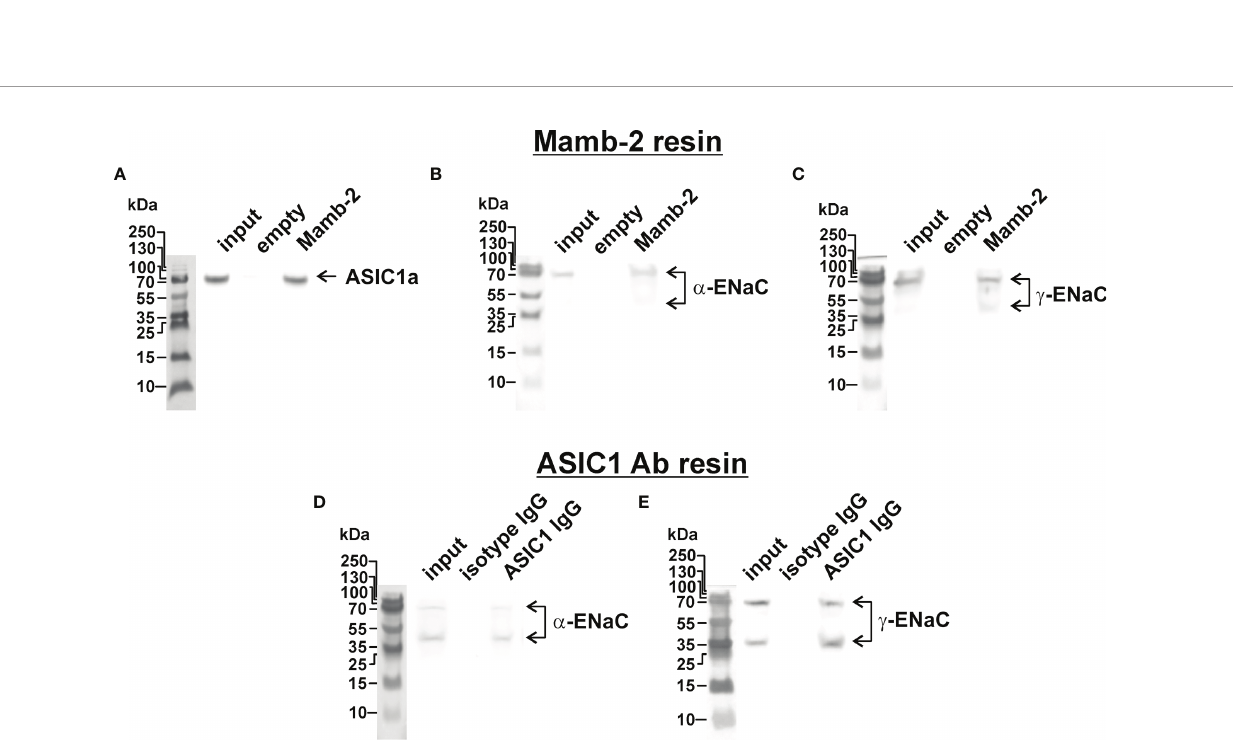
FIGURE 6 | Investigation of mambalgin-2 interaction with ASIC1, a -ENaC, and g -ENaC subunits in A549 cells. Western blot analysis of the ASIC1 (A) , a -ENaC (B) , and g -ENaC (C) subunits extraction from the membrane fraction of A549 cells by af fi nity chromatography using NHS-Sepharose resin coupled with mambalgin-2 (n = 4). Whole Western blotting membranes are shown in Figure S7 . Western blot analysis of the a -ENaC (D) and g -ENaC (E) subunits extracted from the membrane fraction of A549 cells after its precipitation using Protein A-agarose conjugated with ASIC1-antibody (n = 4). Whole Western blotting membranes are shown in Figure S8 .